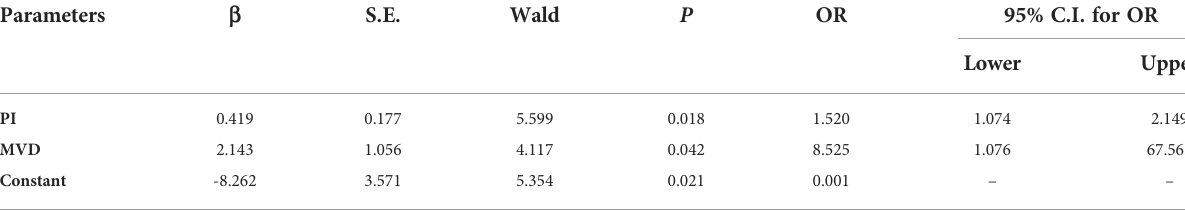
TABLE 3 Multivariate logistic regression analysis of quantitative parameters in the diagnosis of benign and malignant breast masses.